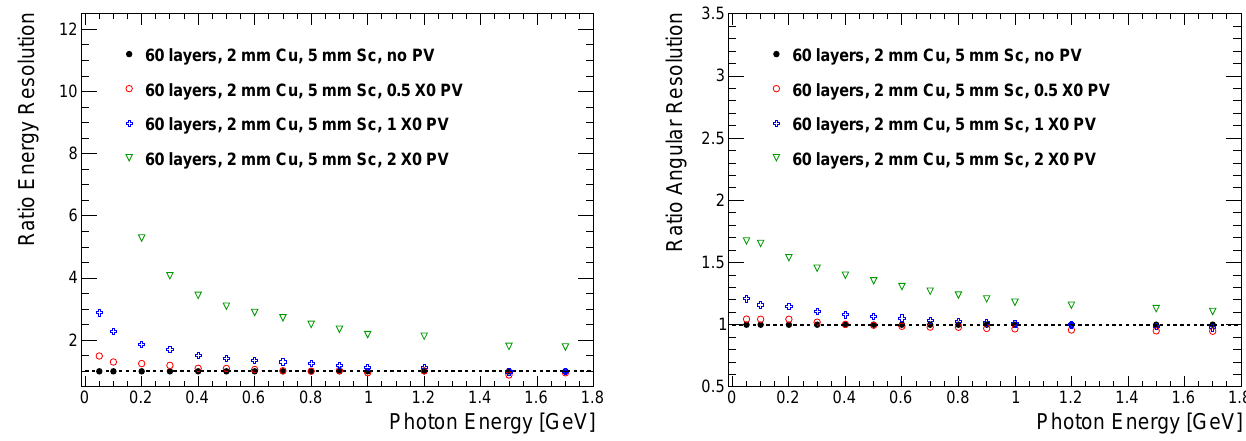
Figure 51. Influence of the pressure vessel thickness on the ECAL energy ( left ) and angular resolution ( right ). The points are the ratio of the absolute energy or angular resolution relative to the value without a pressure